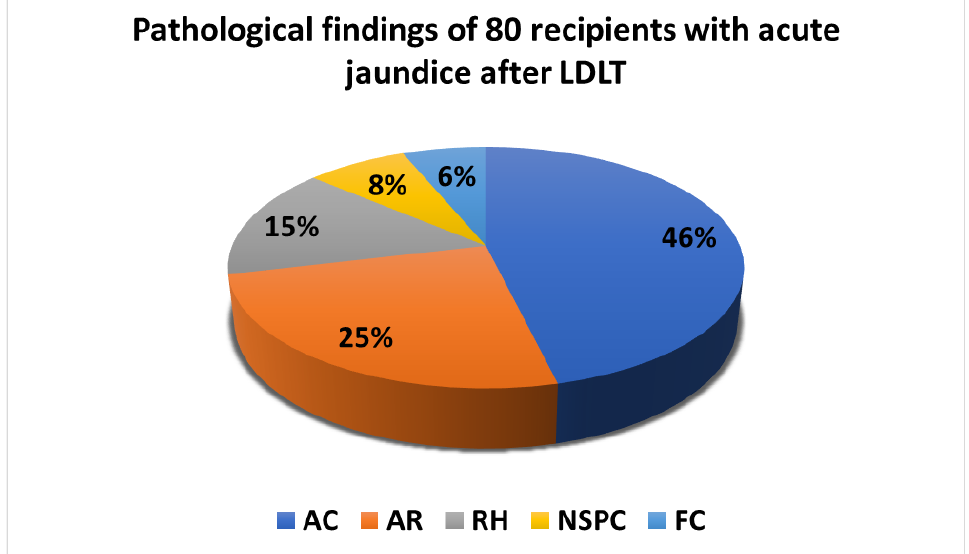
Figure 1. Pathological findings of 80 recipients with acute jaundice after living donor liver transplantation. AC: acute cholangitis; AR: acute cellular rejection; RH: recurrent hepatitis; NSPC: non- specific pathological change; FC: fatty change; LDLT: living donor liver transplantation.